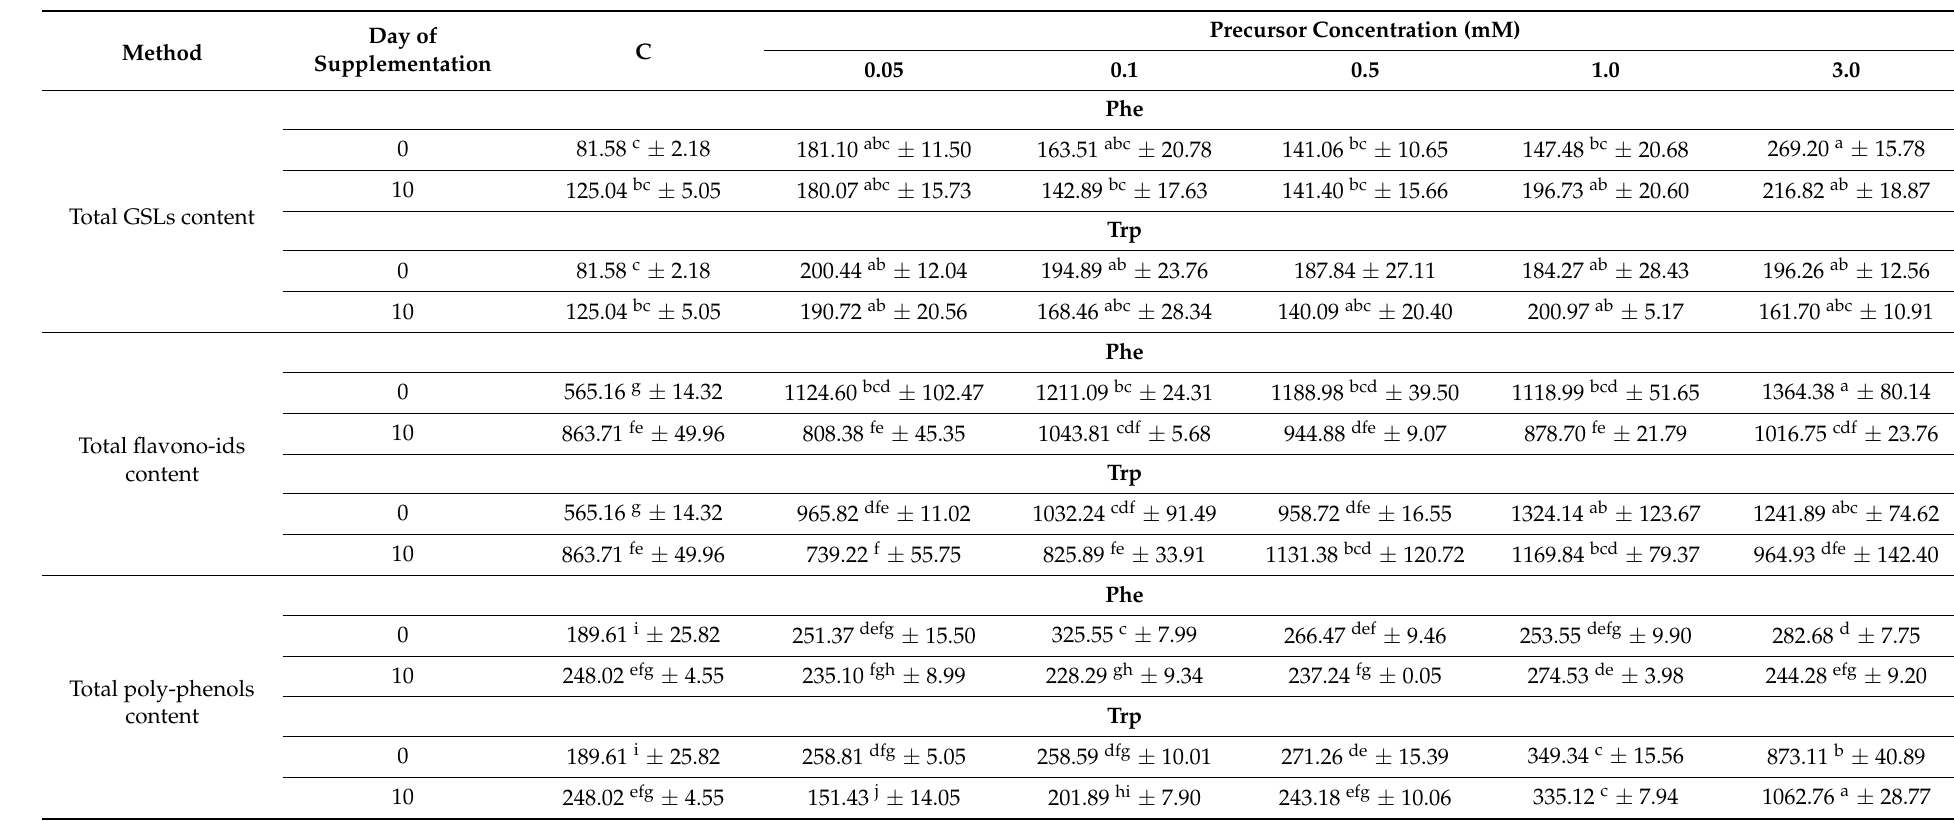
Table 4. Total amounts of GSLs (mg SIN/100 g DW ± SD), flavonoids (mg RE/100 g DW ± SD), and polyphenols (mg GAL/100 g DW ± SD) in bioreactor-grown N. officinale microshoot cultures after precursor